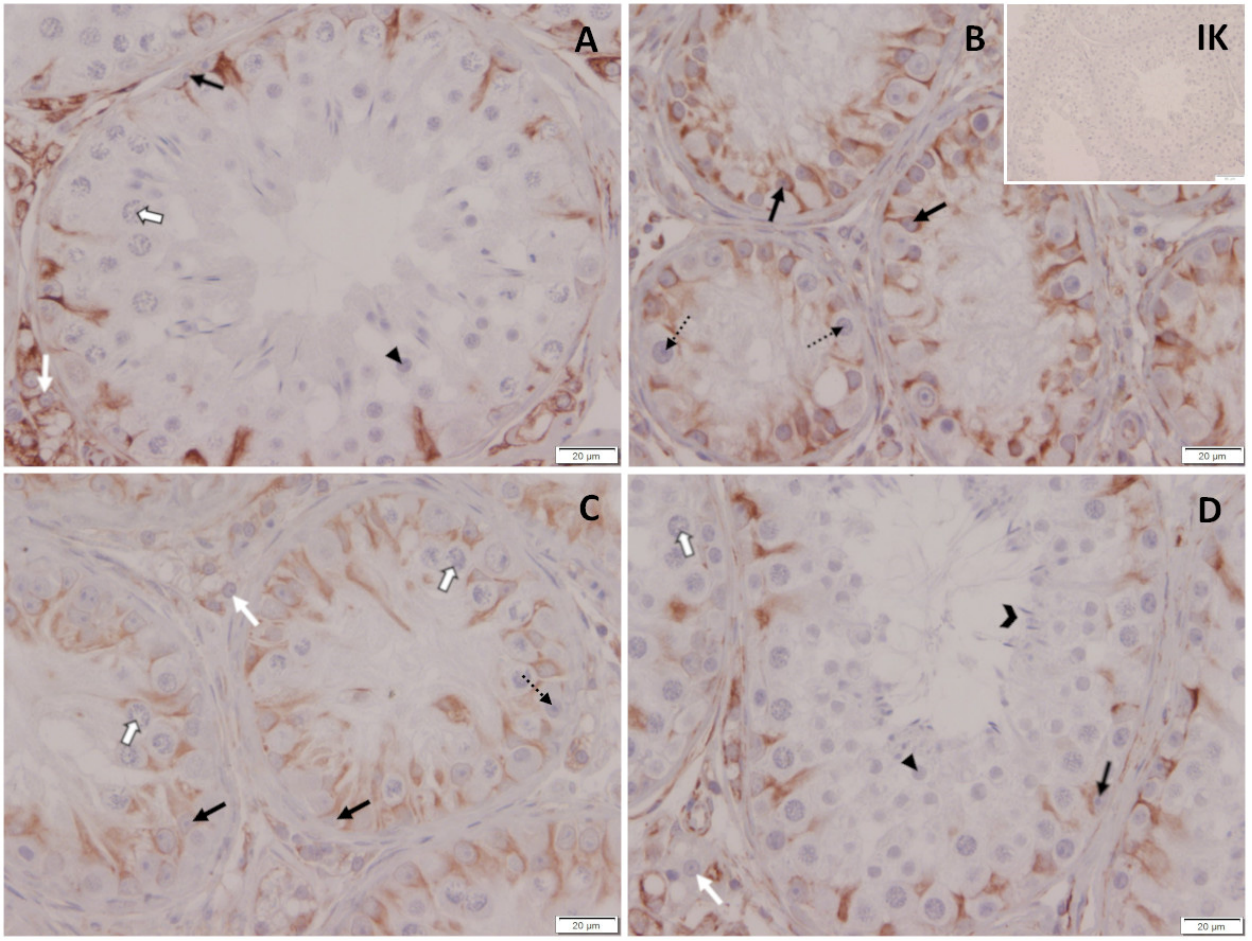
Figure 12. ( A – D ): Histological evaluation of testicular tissue of ( A ) saline-treated control dog and ( B – D ) deslorelin-treated dogs. (A) Normal spermatogenesis. ( B ) Arrest of spermatogenesis at the level of spermatogonia. ( C ) Arrest of spermatogenesis at the level of spermatocytes. ( D ) Reversed effects of treatment as indicated by normal spermatogenesis and spermatozoa in the semen sample on D147 after treatment; spermatogonia; spermatocytes; round spermatids; elongated spermatids; Sertoli cells; white arrow, Leydig cells. Figure 13. Immunopositive staining of testicular tissues against Vimentin. ( A ) Saline-treated control dog and ( B – D ) deslorelin-treated dogs. ( A ) Normal spermatogenesis. ( B ) Arrest of spermatogenesis at the level of spermatogonia. ( C ) Arrest of spermatogenesis at the level of spermatocytes. ( D ) Reversed effects of treatment as indicated by normal spermatogenesis and spermatozoa in the semen sample on D147 after treatment; IK: isotype control; Sertoli cells; white arrow, Leydig